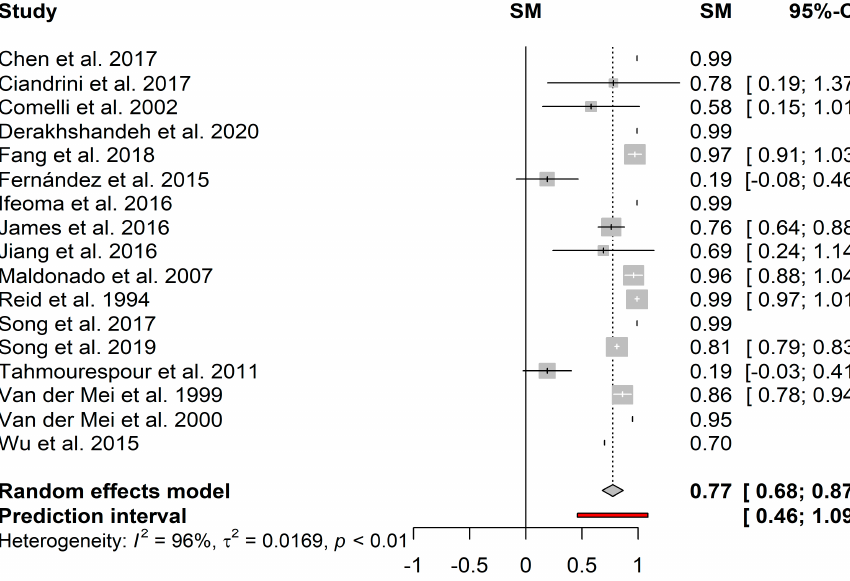
Figure 6. Forest plot of the pooled effect estimates for the proportion of biofilm reduction induced by EPS. The vertical dashes represent the effect estimate, and the horizontal line is the respective confidence interval at 95% (95%–CI) obtained for each study. Gray squares represent the standard deviation of each study, while the gray diamond represents the pooled effect estimates. The red bar represents the predictive interval. Heterogeneity test: I 2 – I 2 test; τ 2 –Tau-squared test.